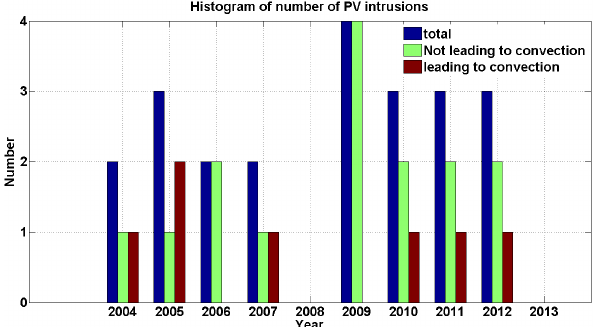
Figure 11. Histogram of total number of PV intrusions at 13.5 ◦ N for the years 2004–2013. Histograms of the number of intrusions leading to convection and of the number of intrusions not leading to convection are also shown for